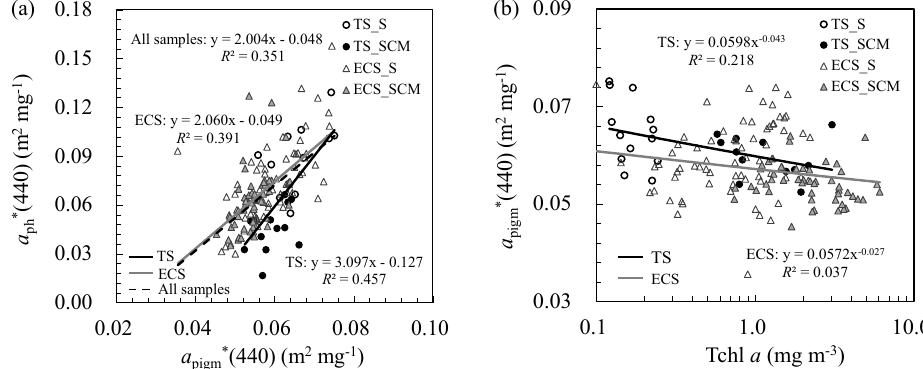
Fig. 8. Variations of a ∗ (440) versus a ∗ (440) (a) and Tchl a (b) in the Tsushima Strait surface (TS_S), Tsushima Strait SCM (TS_SCM), pigm ph East China Sea surface (ECS_S), and East China Sea SCM (ECS_SCM). Solid black and grey lines indicate linear regressions in the Tsushima Strait (TS) and East China Sea (ECS), respectively. Dashed black line is the linear regression for all